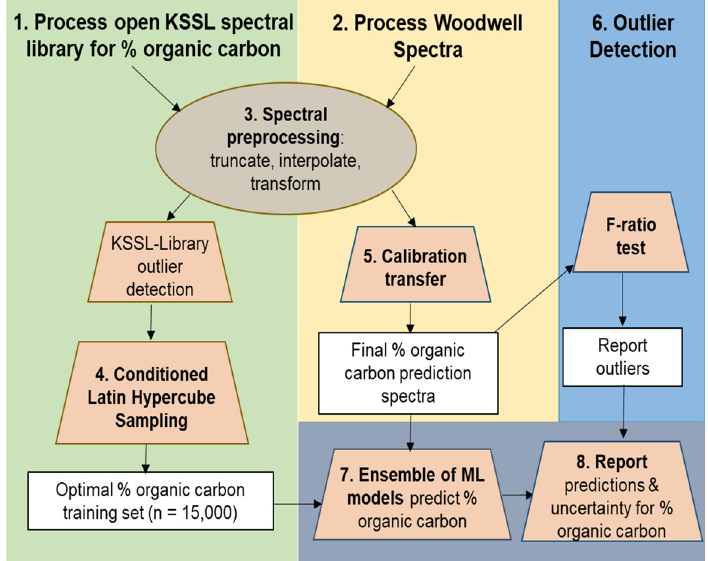
Figure 1. Schematic diagram of workflow for spectra processing and ensemble machine learning (EML) model predictions.